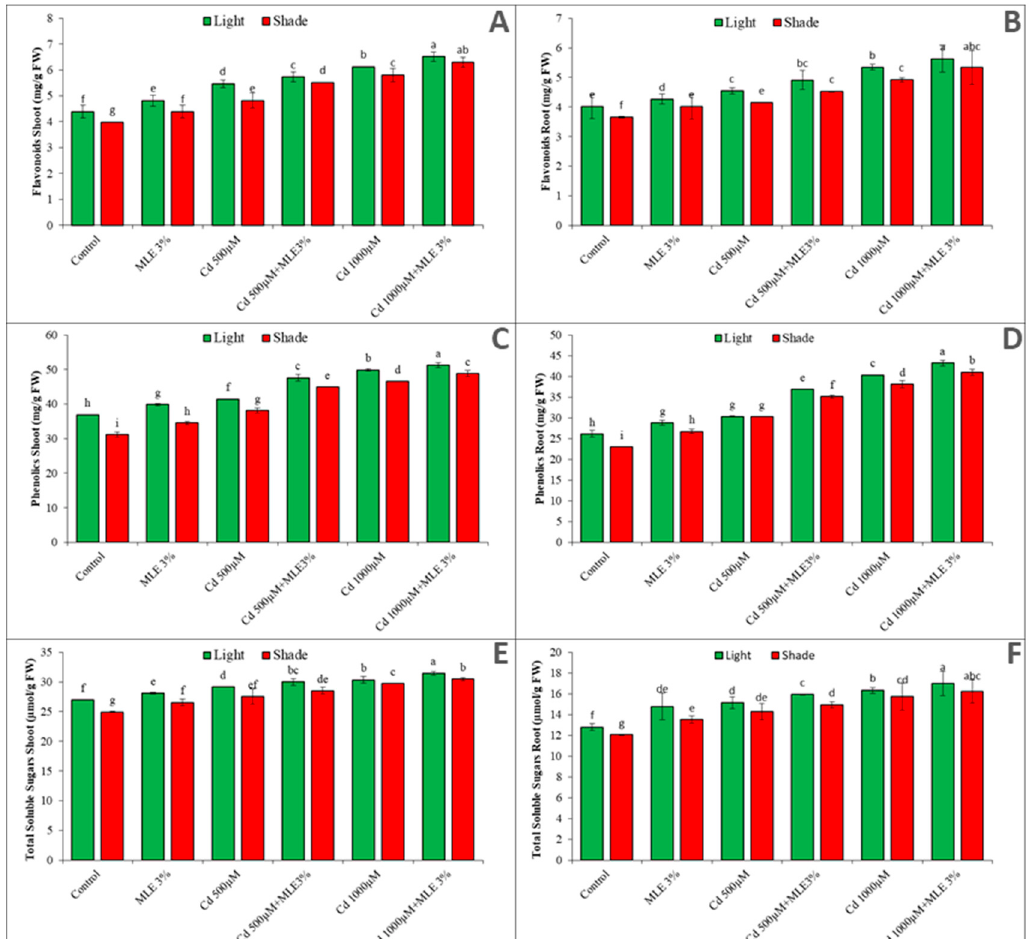
Figure 5. Effect of MLE application on plant osmolytes accumulation ( A ) flavonoids content of shoot ( B ) flavonoids content of root ( C ) phenolics content of shoot ( D ) phenolics content of root ( E ) total soluble sugar content of shoot and ( F ) total soluble sugar content of root, with and without Cd stress under light and subdue light. Different letters above bars represents significant differences ( p < 0.05) at each measured point. Values represent mean ± SE of three replicates of each treatment.